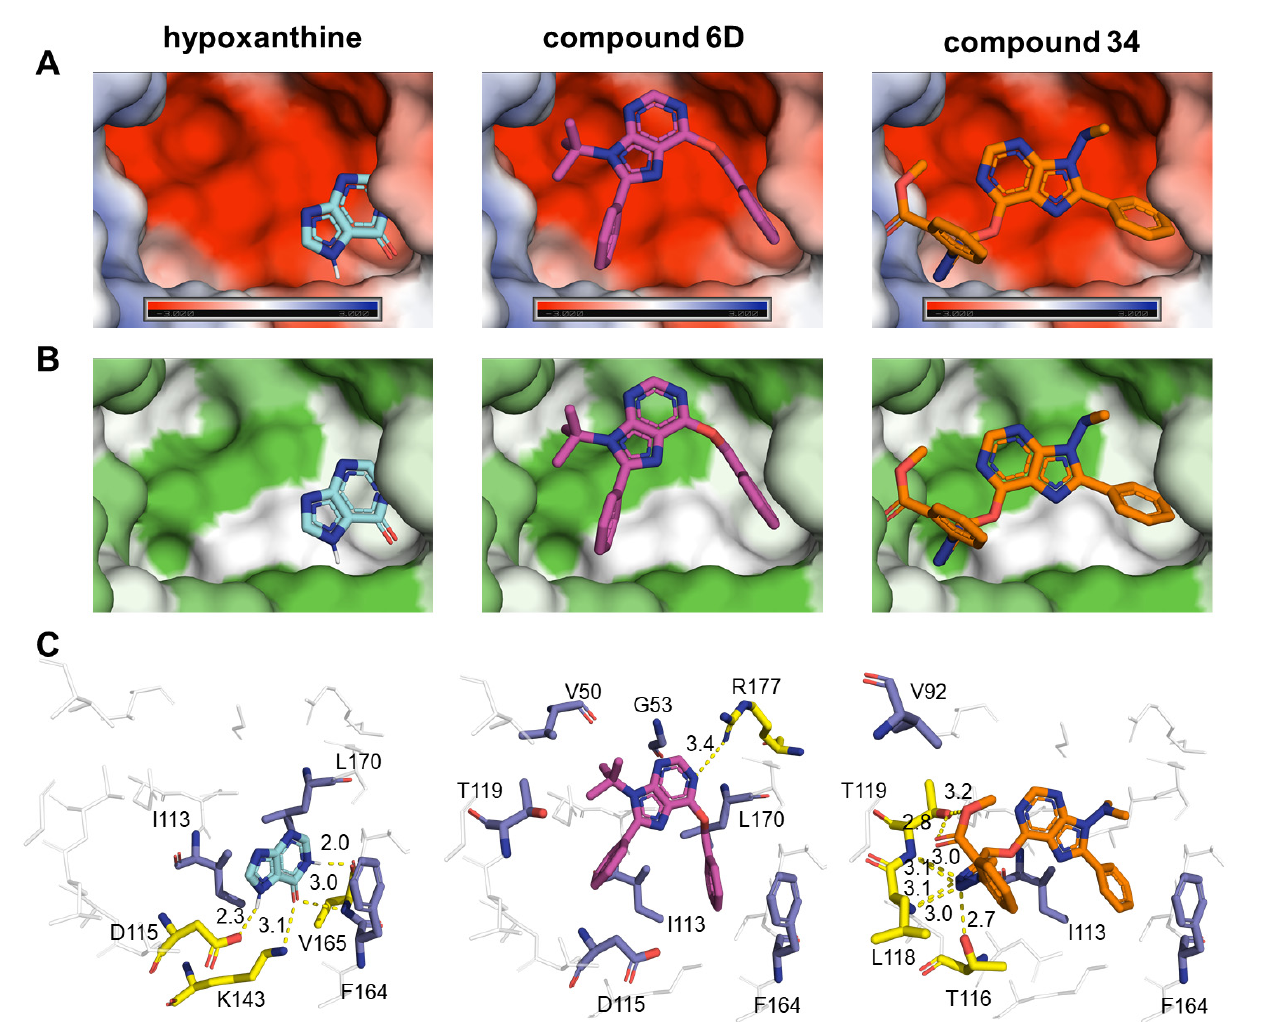
Figure 8. Binding of natural ligand and hit compounds with Tc HGPRT. ( A ) Electrostatic surface view of the binding pocket of Tc HGPRT. ( B ) Hydrophobicity surface view of the binding pocket of Tc HGPRT. ( C ) Zoomed-in view of the interactions between HGPRT active site residues and their corresponding natural ligands or hit compounds. In panel C, residues that form hydrophobic interactions at a maximum distance of 3.9 Å are shown as purple sticks, and those that form H bonds as yellow sticks, while non-interacting residues are grey sticks. Expected H bonds are represented in yellow. In panel B, the hydrophobicity surface map was generated using the Kyte–Doolittle hydrophobicity scale.